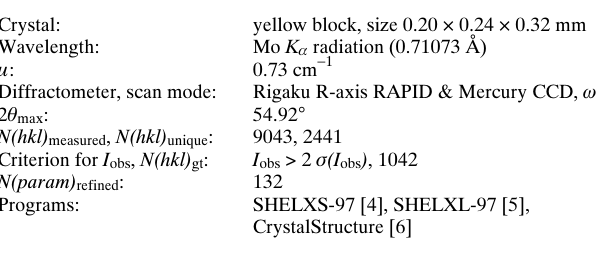
Table 1. D a t a collection a nd h a ndling.